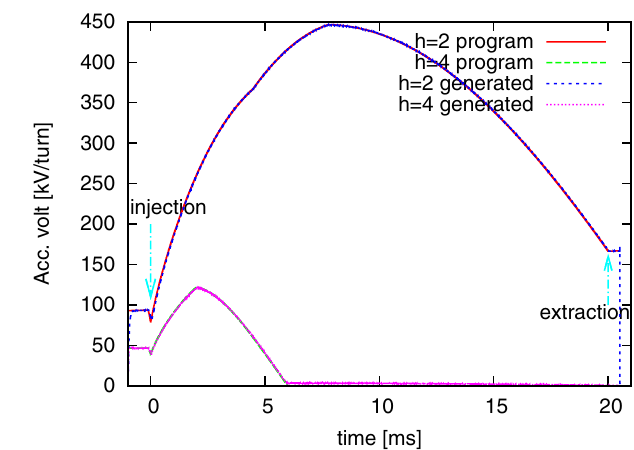
FIG. 14. (Color) Fundamental rf frequency is 1.5 MHz. Superposed rf signal (channel 3) and single harmonic waveform (channel 4). FIG. 16. (Color) Program and generated